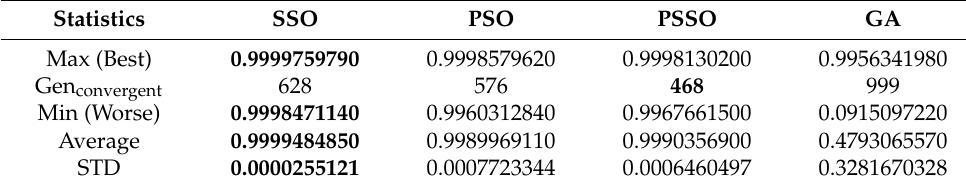
Table 6. The statistics of system reliability for benchmark 2.